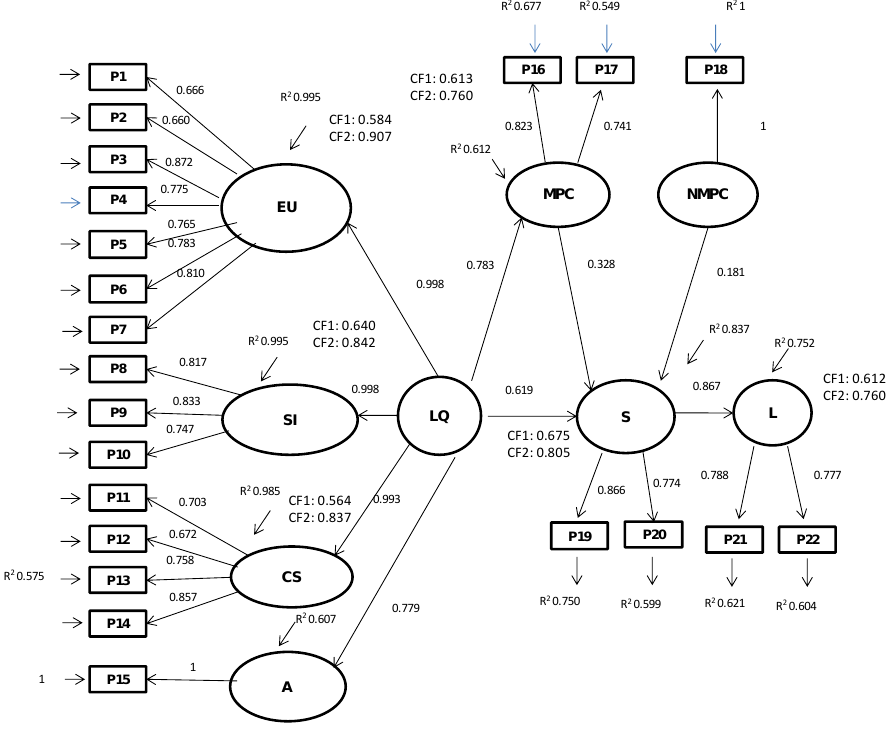
Figure 2. Estimation of the e-TPP Model.